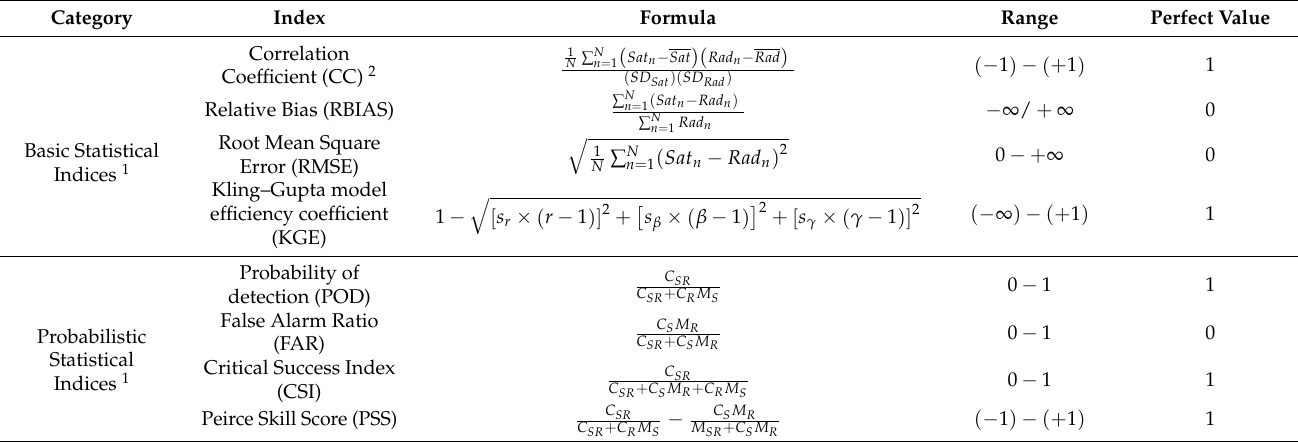
Table 1. Statistical performance indicators used for evaluation of the satellite